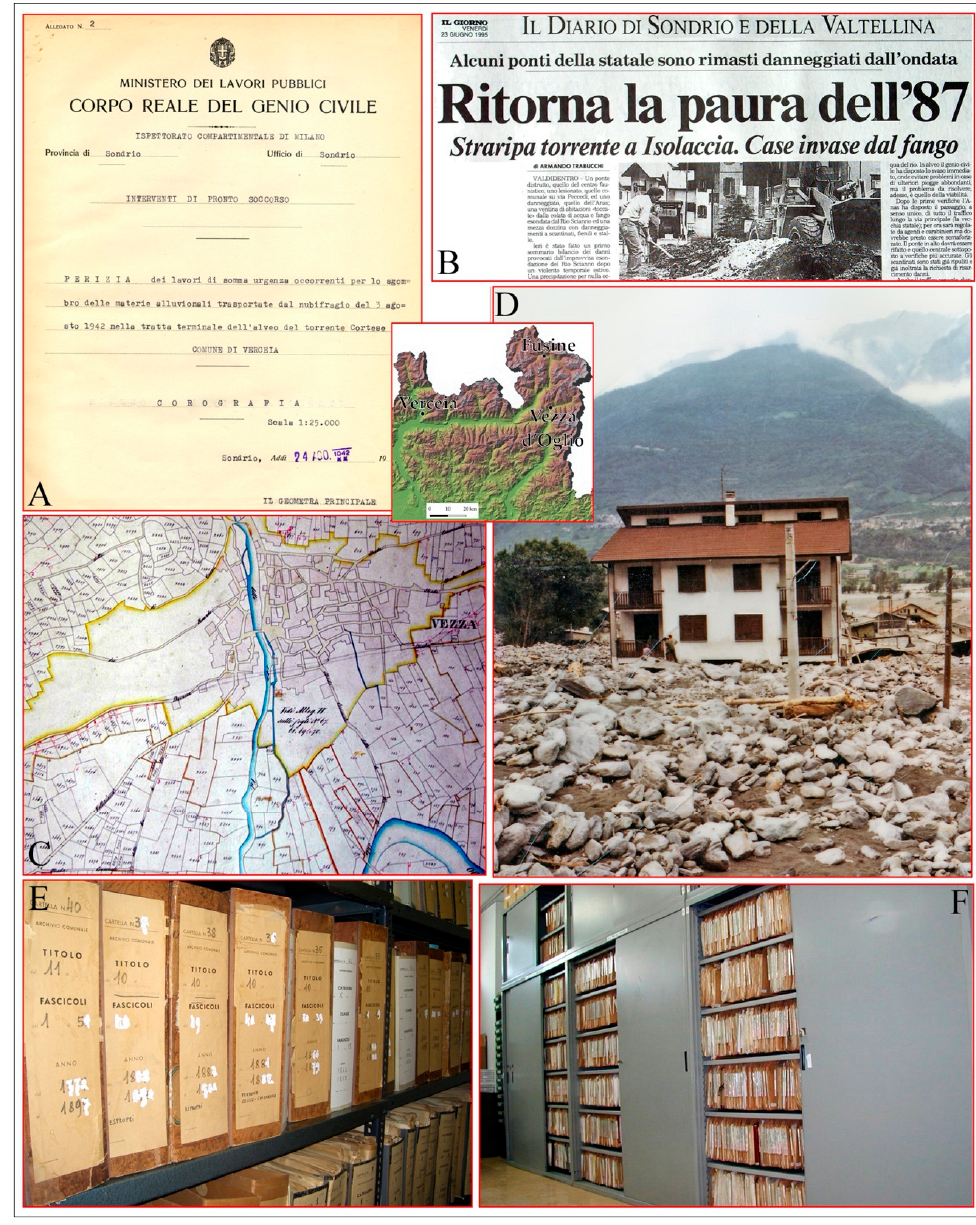
Figure 4. Examples of documents collected and used for the historical research of rainfall-induced landslides in the Lombardy Region. ( A ) Municipal archives: report on the damage caused by the debris flows of the Cortese Stream during the event that occurred on 3 August 1942 in the Verceia municipality; ( B ) journalistic sources; news from the “Il Giorno” newspaper on the event of 22 June 1995 in Valtellina; ( C ) State Archives of Brescia: detailed map of the Vezza d’Oglio municipality (Valcamonica) produced during the Kingdom of Lombardy-Venetia (around 1850); ( D ) images collected from local photographers: serious damage in the Fusine town (Valtellina) due to the debris flows of Madrasco Stream on 18 July 1987; ( E ) archive of the Lombardy Region, Sondrio local headquarters: folders containing documents concerning the interventions on the streams made towards the end of the 19th century; ( F ) historical archive of the CNR-IRPI of Turin: the richest Italian archive concerning floods, landslides, and mud-debris flows in Northern